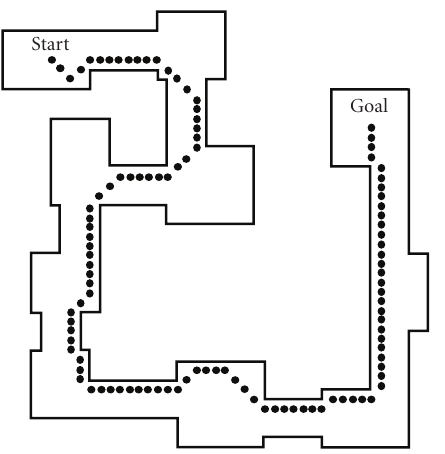
Figure 5: Standard pathfinding (i.e., with no beautifying treat- ment) for trial 18.